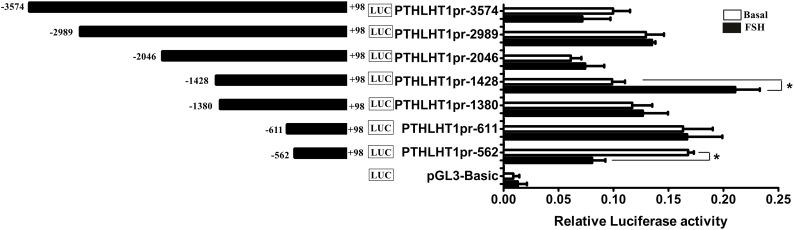
Promoter analysis of chicken PTHLH gene and the effects of FSH on PTHLH promoter activities in pre-TCs. The numbering refers to the transcription initiation site designated as +1. For deletion constructs of the chicken PTHLH promoter and an internal control vector pGL 4.74, luciferase activity was calculated by dividing the firefly luciferase activity by the Renilla luciferase activity. Each bar represents the means ± SEM. ∗p < 0.05 versus basal.